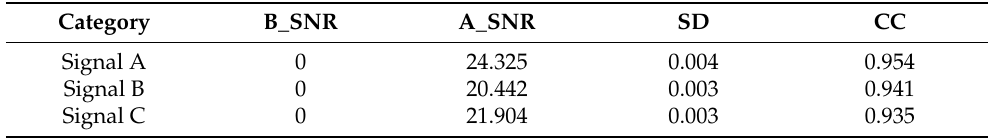
Table 1. Analysis of the noise reduction effect for MS